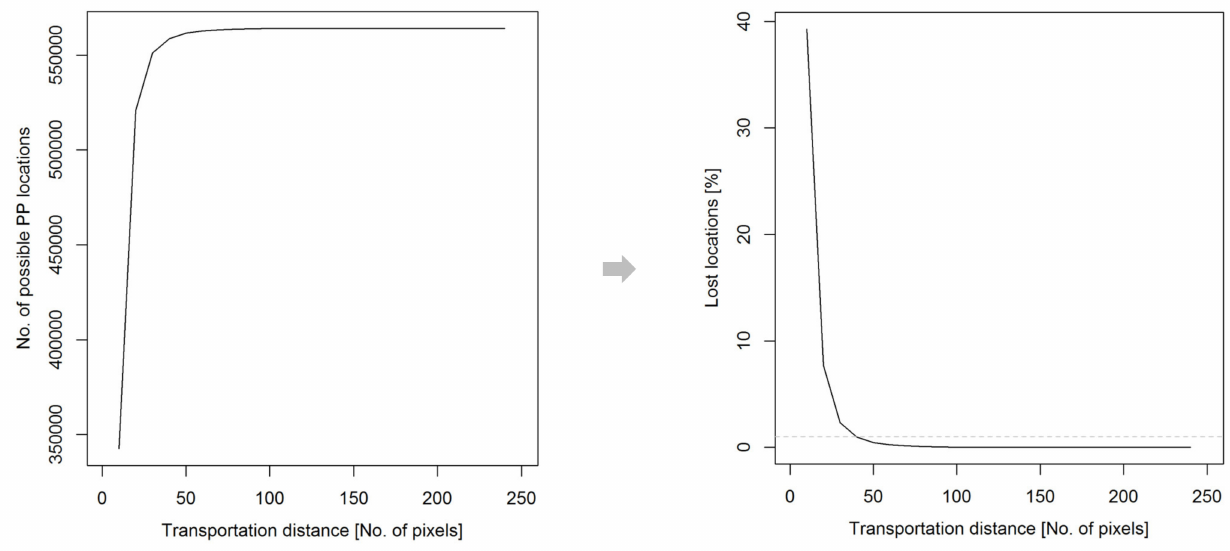
Figure 8. Transportation distance vs. number of possible locations for new RGPs ( left ) percentages of lost locations ( right ). Note that the dotted lines signify about 3% lost location. Note: When the transport distance is 50 km, 350,000 possible location for new RGP is found which is the shortest. While 250 km transport distance produces 550,000 new RGP’s potential